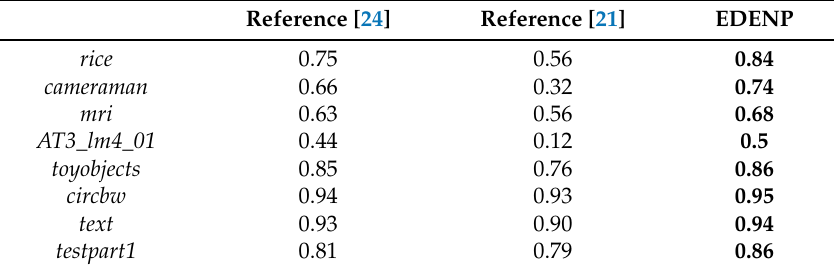
Table 3. The edge confidence degree.